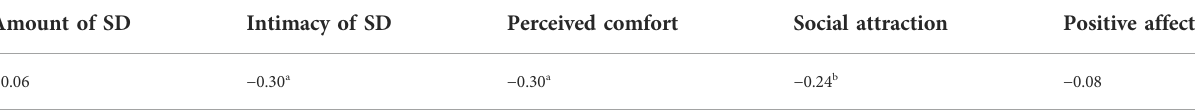
TABLE 5 Pearson ’ s correlation results of failed speech recognition attempts with self-disclosure (SD), perceived comfort, social attraction, and positive affect change. Amount of SD